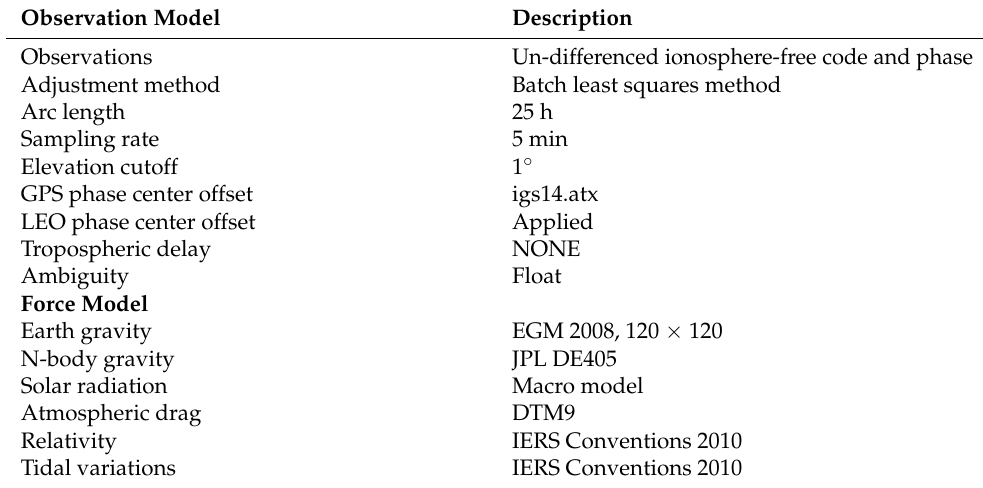
Table 5. LEO POD configuration.